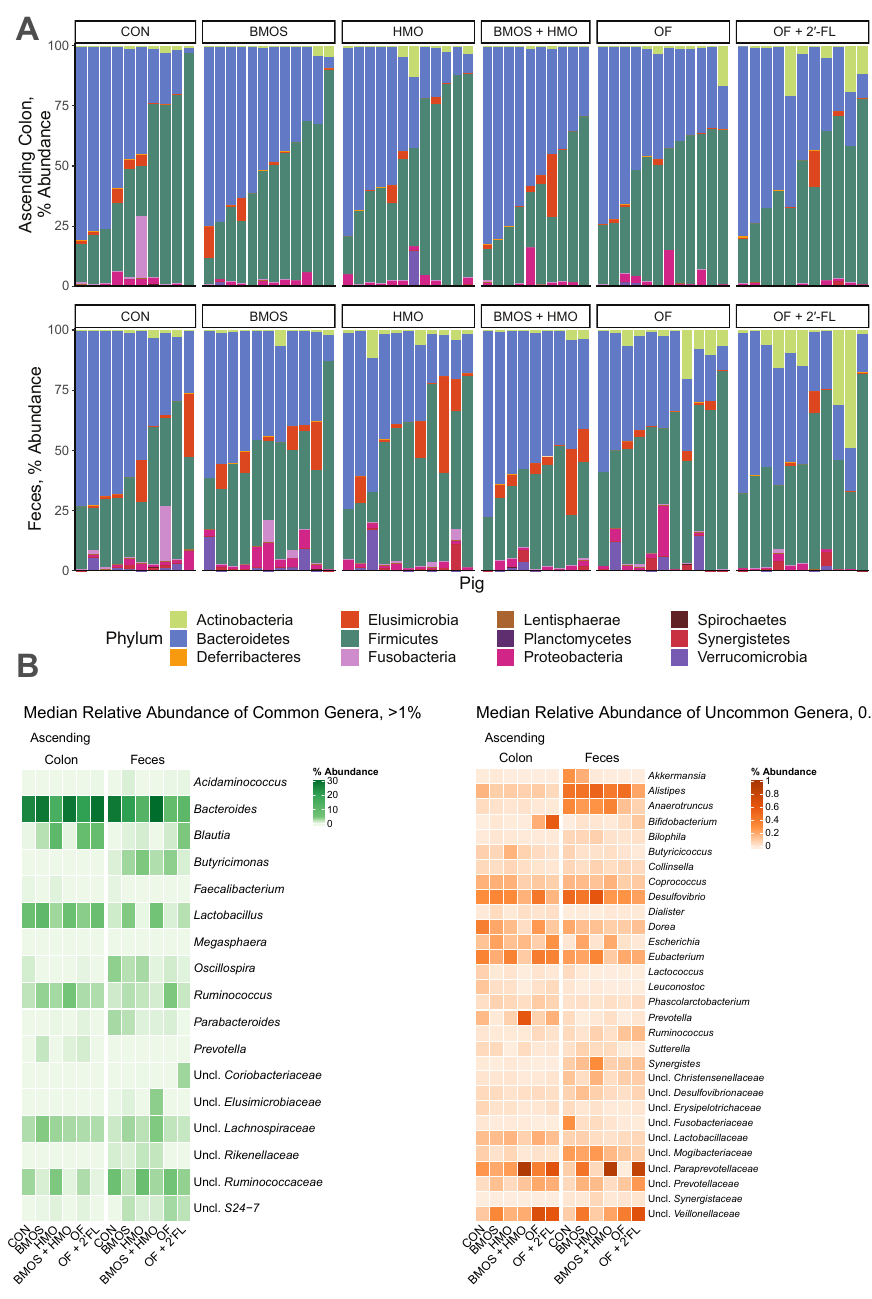
Figure 2. ( A ) Relative abundance of taxa at the phylum level in the ascending colon and feces. Each bar represents an individual pig. ( B ) Relative abundance of common and uncommon taxa at the genera level. Groups with a median abundance less than 0.05% for any given taxa are not shown. Abbreviations: Uncl., unclassified; CON, control group; HMO, pigs fed human milk